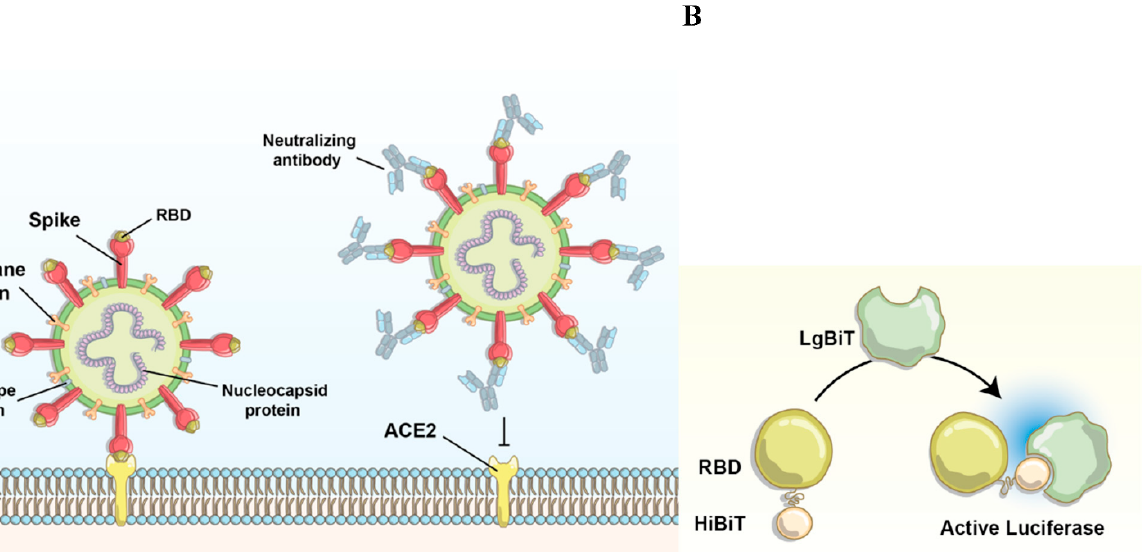
Figure 2. HiBiT-RBD is expressed in both cell lysates and supernatants. ( A ) HEK293T cells were transiently transfected with HiBiT-RBD or pcDNA3.1 empty vector control (1 μ g total). Harvested whole cell lysates and supernatants were immunoblotted and probed for RBD. Beta-actin was used as a loading control, and Ponceau staining shows total protein levels. ( B ) Relative luminescence signal with and without LgBiT-substrate treatment of both cell lysates and supernatants.